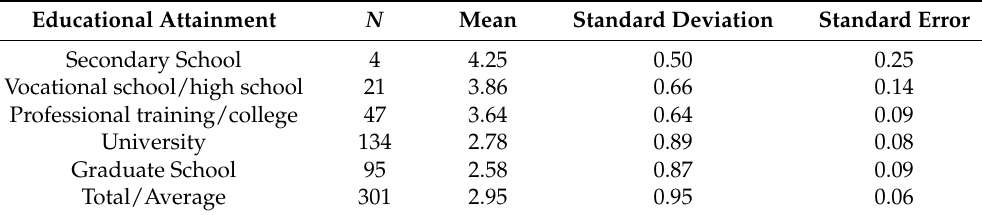
Table 4. Description of different educational attainment.